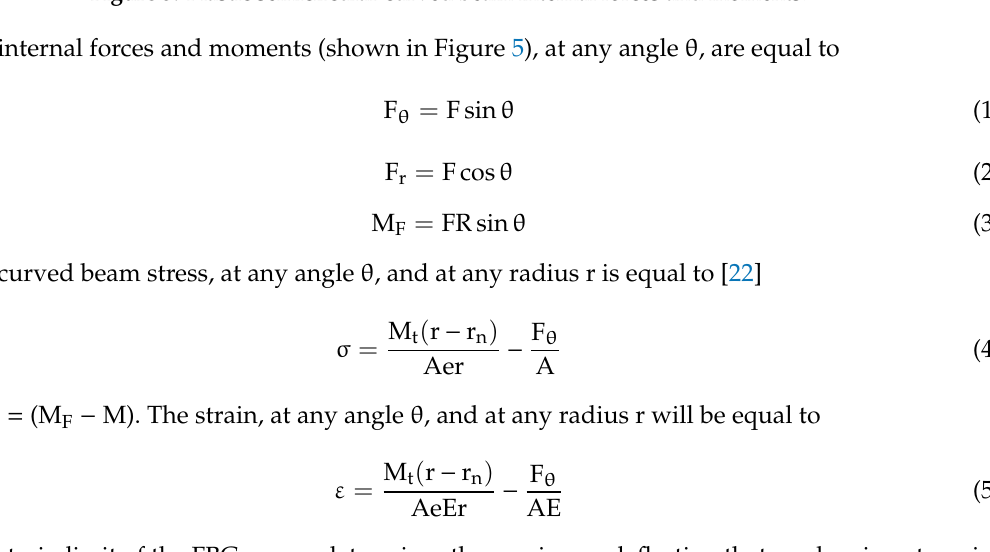
Figure 5. Plastic semicircular curved beam internal forces and moments.